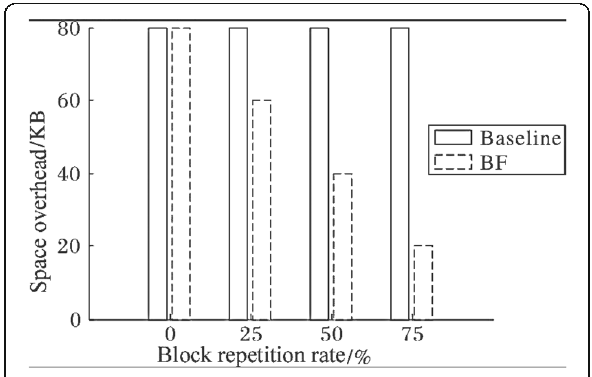
Fig. 9 Space overhead of cryptographic convergence secret key. scheme encryption and convergence